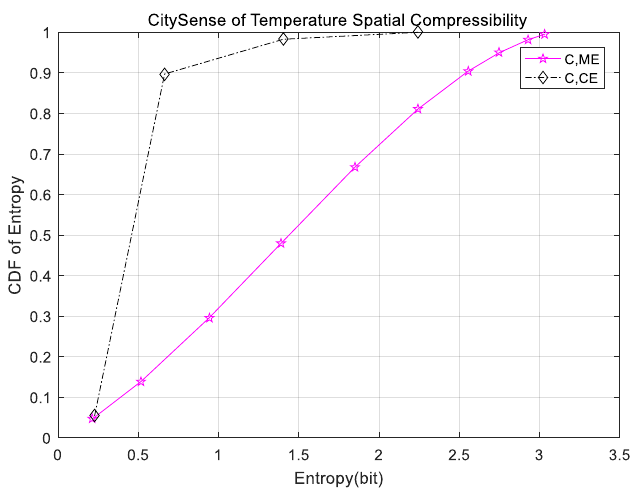
Figure 1. Spatial compressibility of LUCE-EPFL temperature.